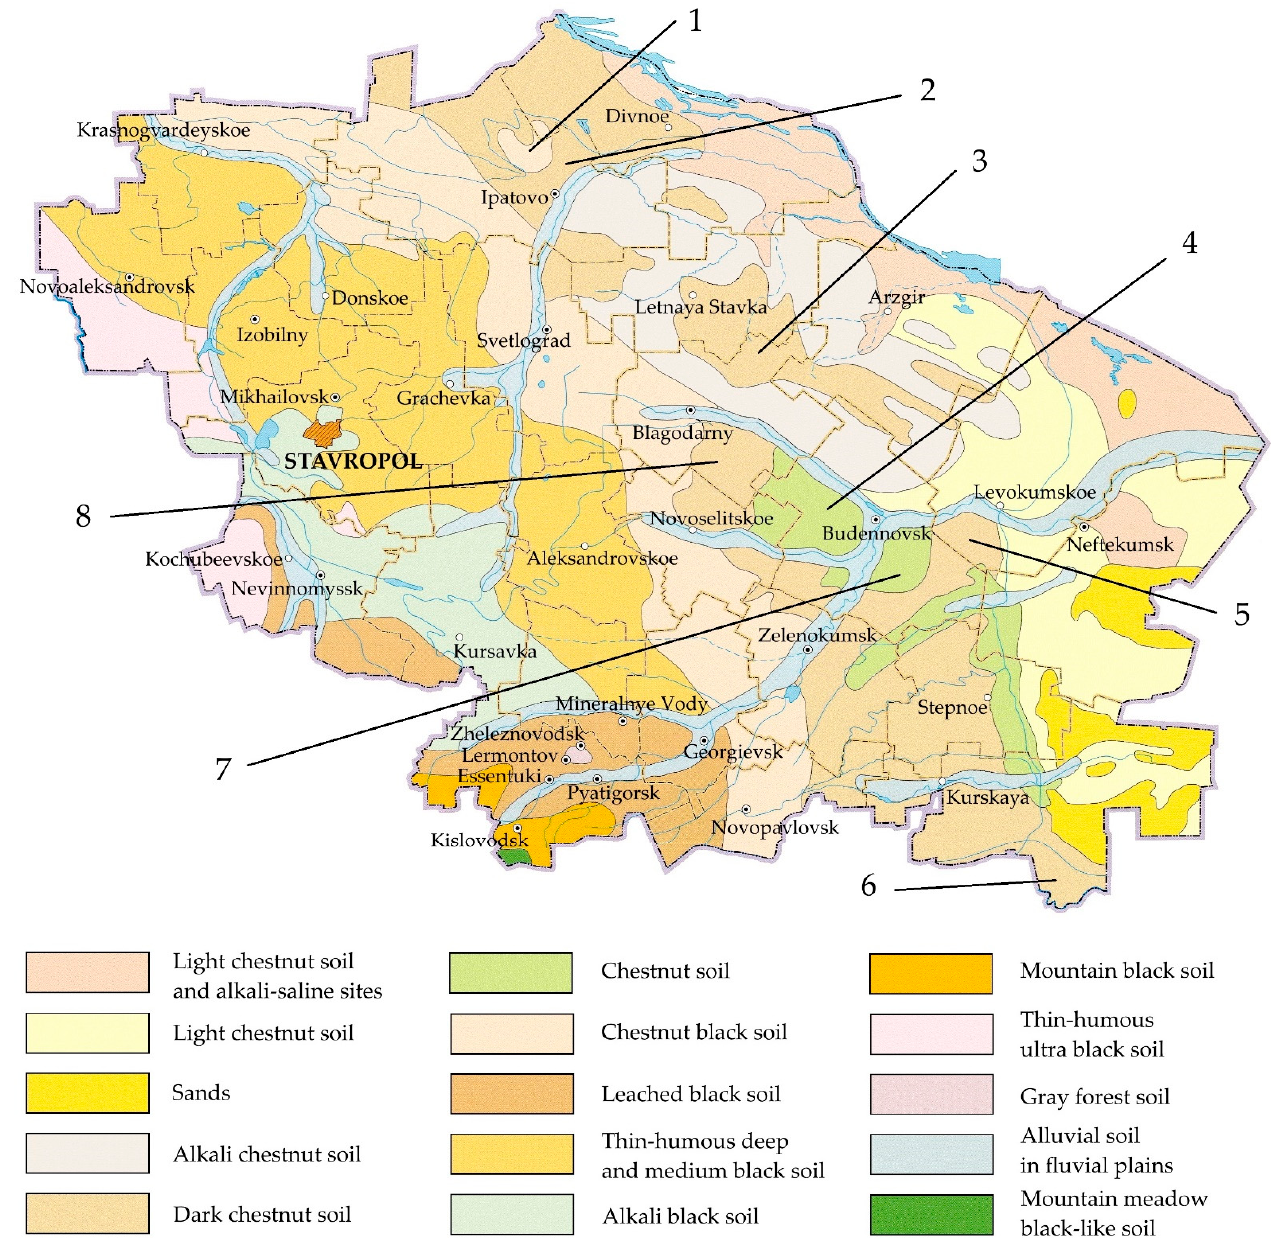
Figure A4. Relocation of sites for production winter wheat in Central Fore-Caucasus. Note: 1–8 = potential sites (see Table 6 for details). Source: authors’ development. Table A1. Cochrane–Orcutt estimation results.